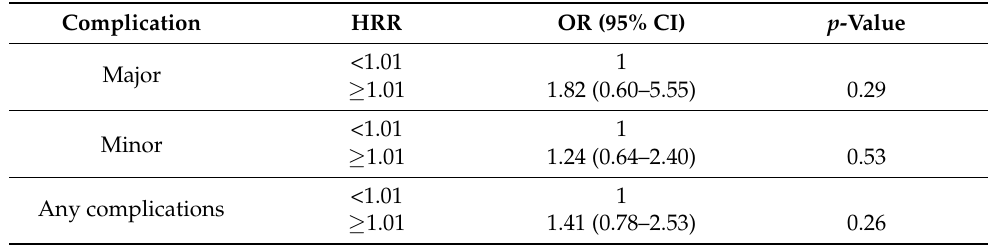
Table 4. Estimates of the risk for major, minor, and any grade complications (odd ratios) according to the HRR median